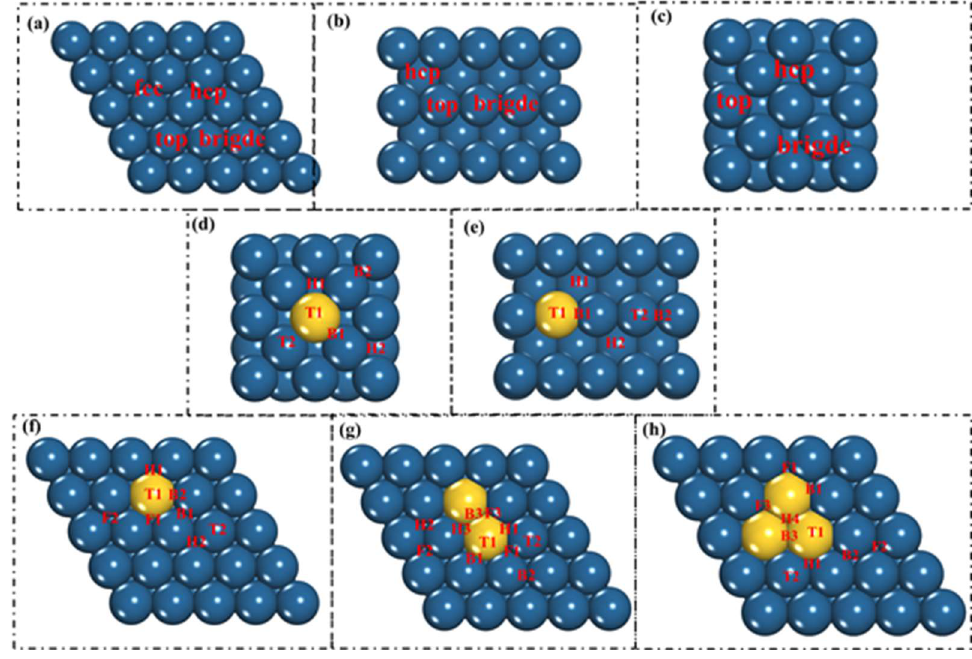
Figure 2. Possible adsorption sites of NO on ( a ) Pt(111), ( b ) Pt(220), ( c ) Pt(200); Au single-atom doped ( d ) Pt(200), ( e ) Pt(220), ( f ) Pt(111) surfaces; and ( g ) Au dimer, ( h ) Au trimer Pt(111) doped. Steel blue and yellow represent Pt and Au atoms, respectively.